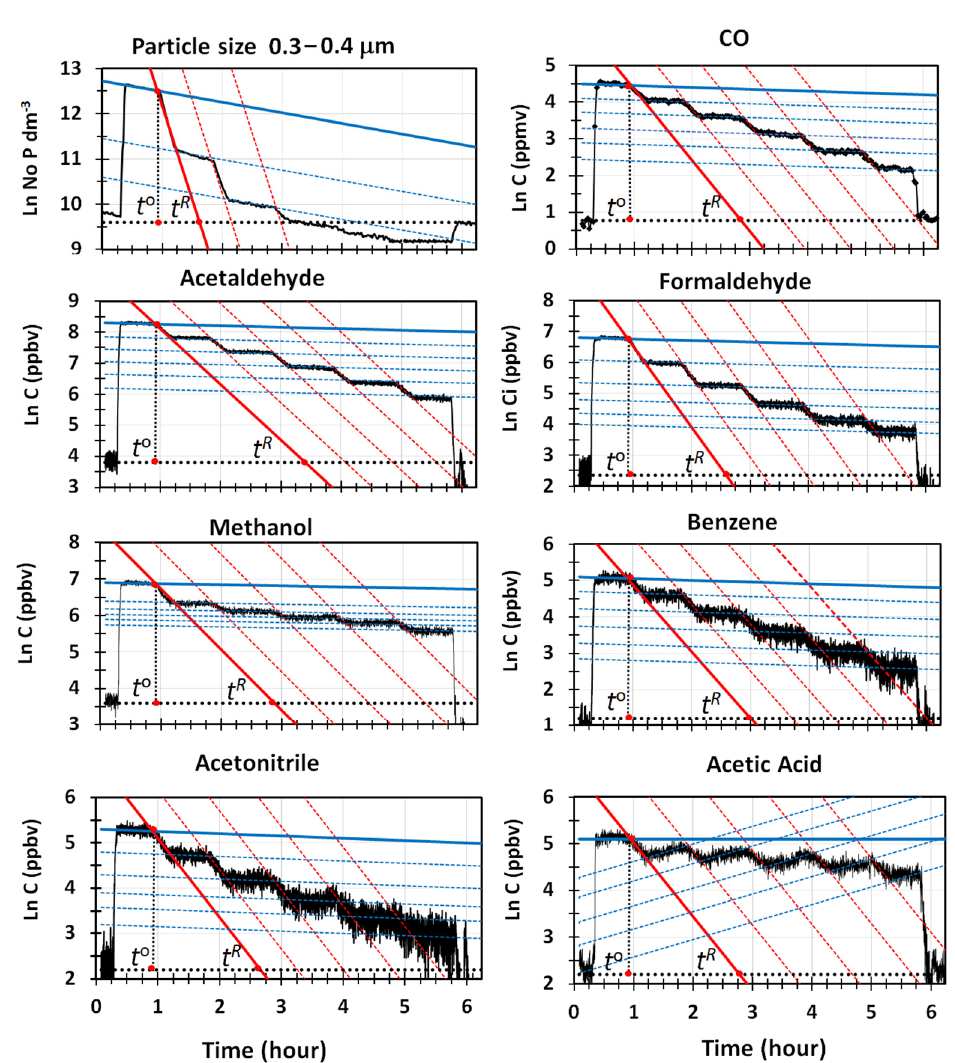
Figure 5. Semi-logarithmic plots of selected pollutants vs. time recorded in testing room during the pulsed experiment performed with diesel exhaust emission using the GIOEL air cleaner at the maximum flow rate. The meaning of the lines and symbols are the same as in the previous figures. The various curves identify the pair of regression lines that were generated at each cleaning step according to a pulsed sequence t 0 n = t 0 + nt N , where n = number of steps, t N the time between the steps and t 0 the initial steps indicated in the thick solid line in red, in the